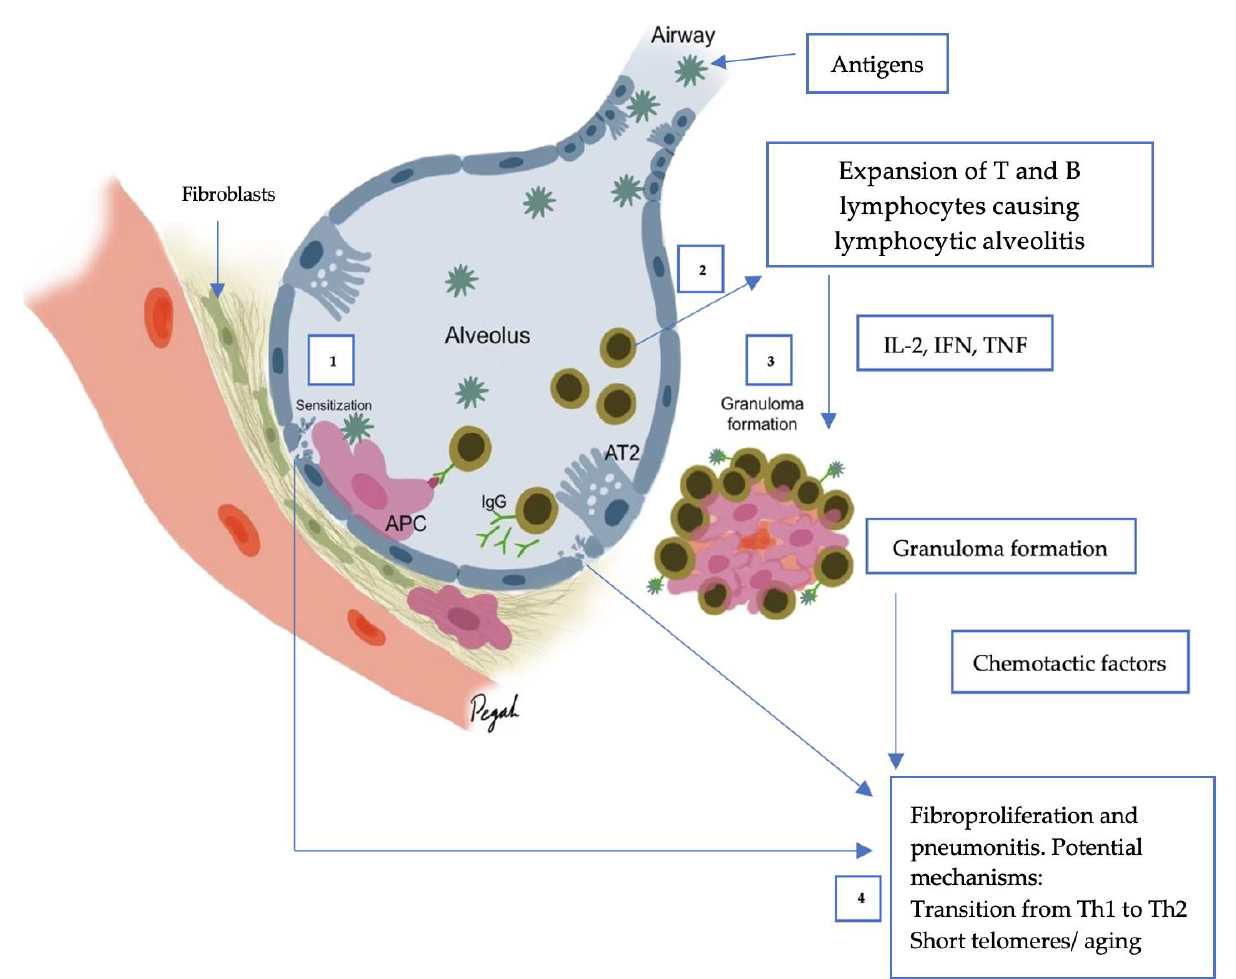
Figure 1. Immunopathogenesis of HP. Inhaled antigens interact with antigen-presenting cells (APCs, i.e., macrophages, dendritic cells) via pattern recognition receptors including toll-like receptors (1). APCs stimulate a T-helper 1 cell (Th1) response. Neutrophils are present in early disease. Stimulated plasma cells (B cells) (2) produce IgG antibodies (humoral response) which triggers the complement cascade (3) and enhances macrophages which fuse to multinucleated giant cells and epithelioid cells to form granulomas, mediated by Th1 cytokines. Granulomas produce chemotactic factors which, in combination with dysregulated T cell function, promotes fibroblast proliferation (4). Fibroblasts differentiate into myofibroblasts, produce collagen and extracellular matrix, causing fibrosis.